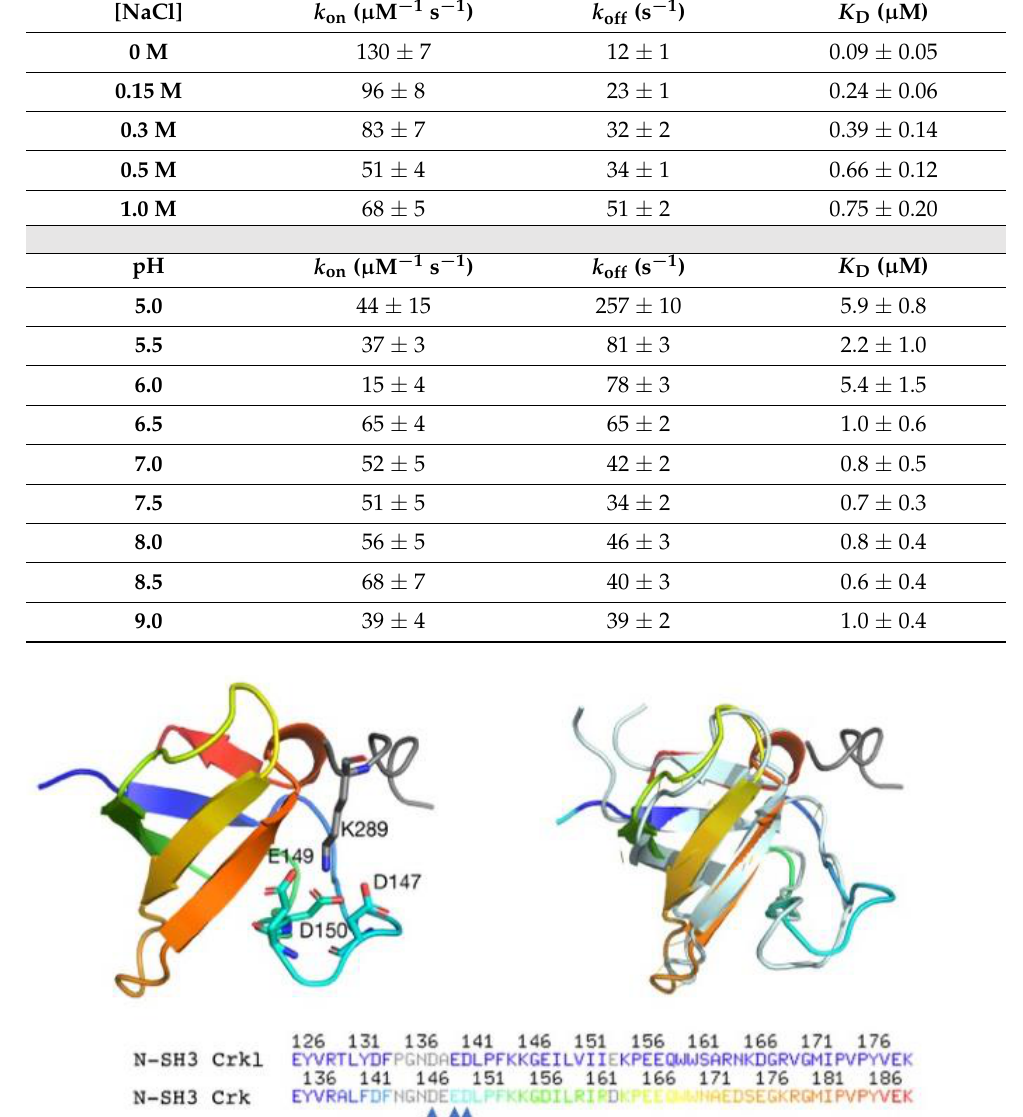
Table 1. Kinetic parameters at different ionic strength conditions and different pH (in presence of 0.5 M NaCl) obtained from linear fitting of data reported in Figures 1 and 2. The NaCl concentrations reported in the left column were added to buffer Hepes 50 mM pH 7.0. N-SH3 WT versus C3G 277–296